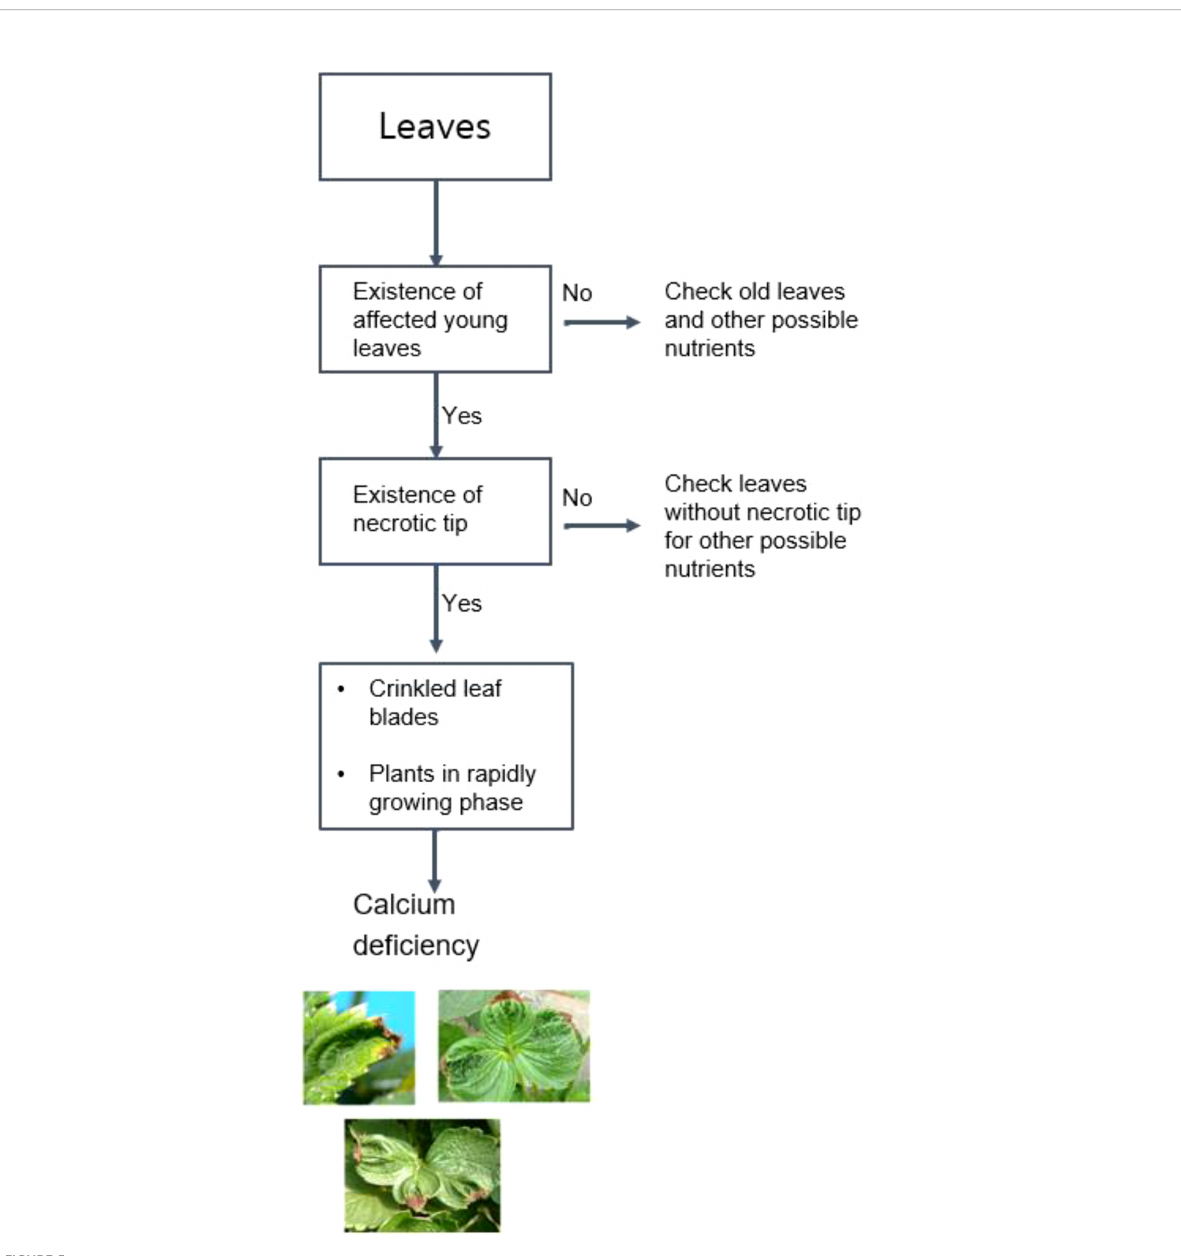
FIGURE 5 Diagnostic fl ow-chart for nutrient stress identi fi cation in